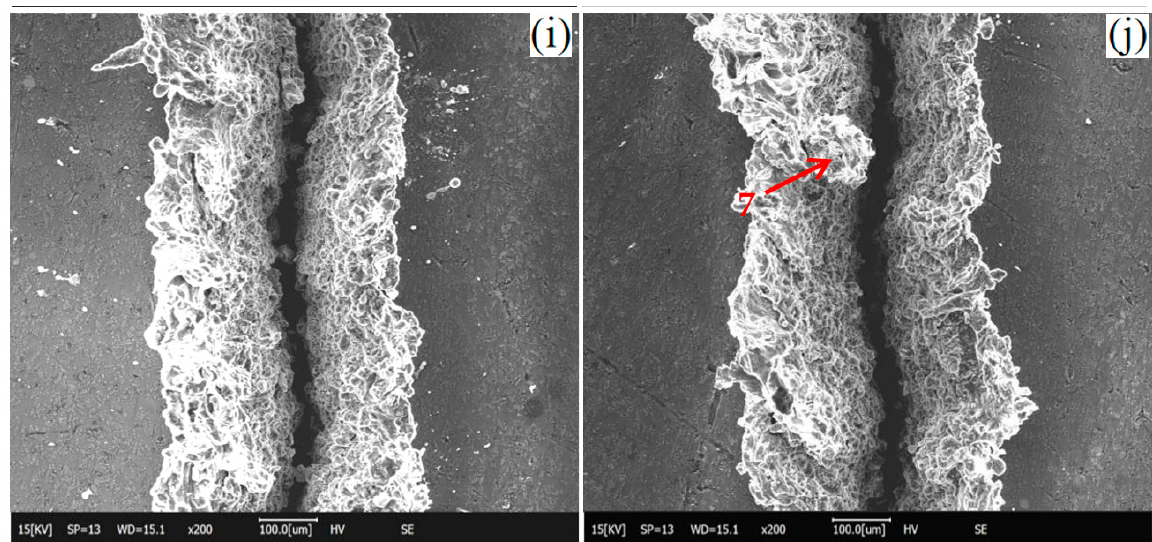
Figure 7. Scanning electron microscope (SEM) image. ( a ) 5 W; ( b ) 10 W; ( c ) 15 W; ( d ) 20 W; ( e ) 25 W; ( f ) 30 W; ( g ) 35 W; ( h ) 40 W; ( i ) 45 W; ( j ) 50 W.